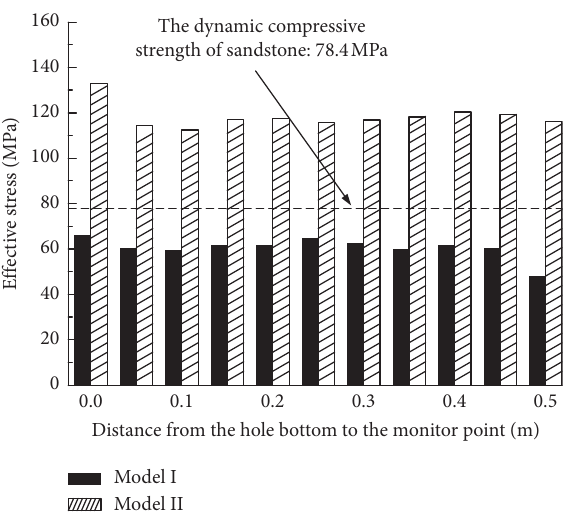
Figure 7: Distributions of effective stress in the two models. Table 7: Physical-mechanical parameters of the surrounding